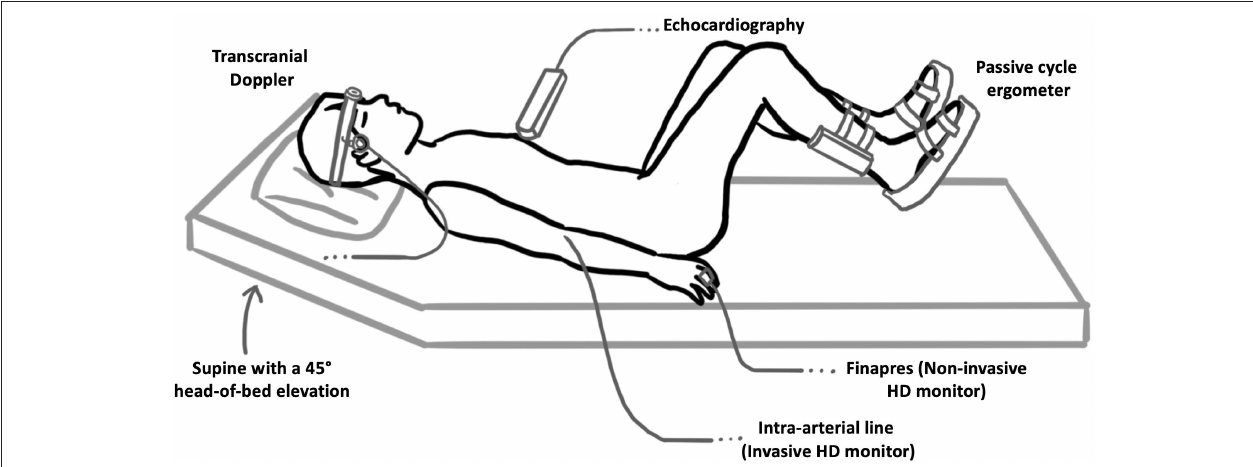
FIGURE 1 | Patient and experimental setup used. Patients were positioned supine with a 45 ◦ head-of-bed elevation and passively cycled using an in-bed cycle ergometer. Transcranial Doppler was used to measure the velocity of blood flow in the middle cerebral arteries (as a surrogate marker of global cerebral blood flow). Gray-scale 2-D echocardiography was used to collect apical 2- and 4-chamber views of the LV at each cycling intensity, which were then used to compute patient EF and GLS at each experimental stage. We used Finapres ® NOVA to measure hemodynamic parameters using pulse wave analysis with additional mean arterial pressure and heart rate monitoring performed through routine care intra-arterial hemodynamic